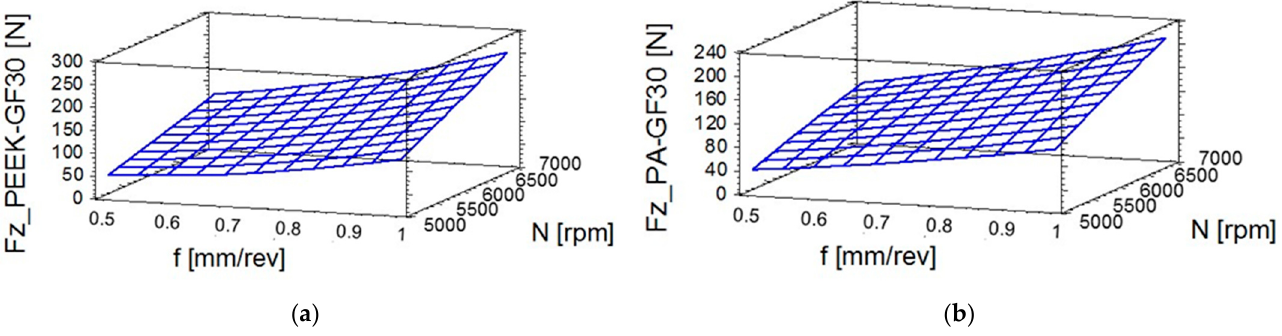
Figure 3. Estimated response surface for thrust forces: ( a ) for Fz_PEEK-GF30 and ( b ) for Fz_PA66- GF30.